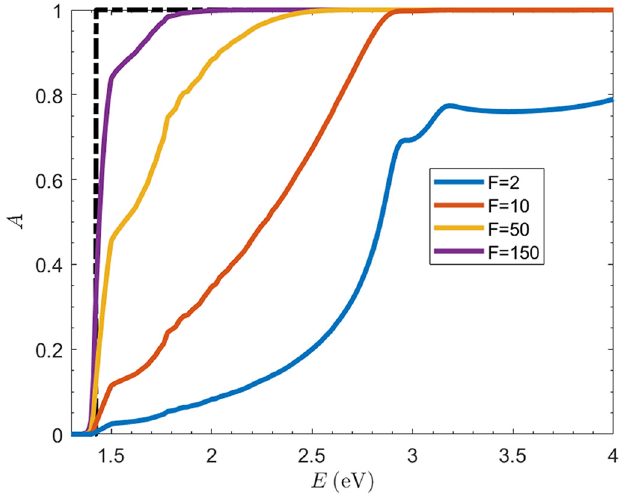
Fig. 1. Absorptivity as a function of the photon energy in 10 nm- thick GaAs for the 4 cases considered, with various light path enhancement factors F . The step absorber is shown for reference (dashed black).